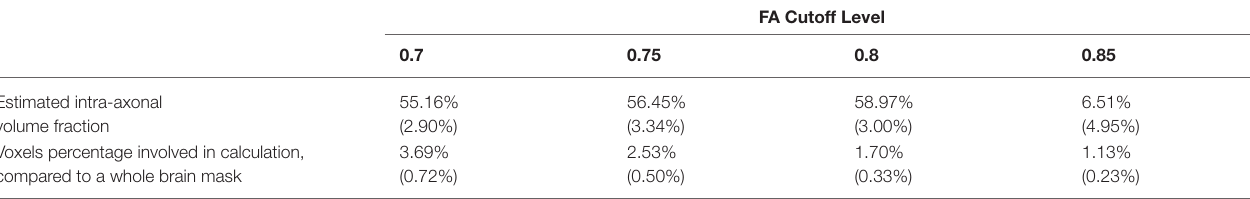
TABLE 3 | Intra-axonal volume fraction.